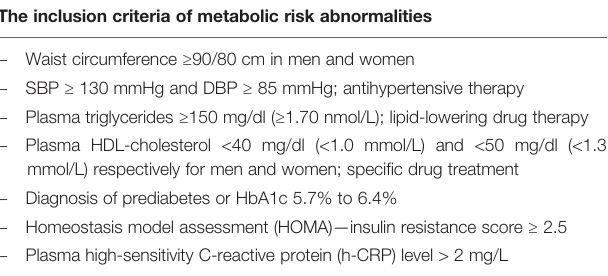
TABLE 1 | The inclusion criteria of metabolic risk abnormalities. The inclusion criteria of metabolic risk abnormalities − Waist circumference ≥ 90/80 cm in men and women − SBP ≥ 130 mmHg and DBP ≥ 85 mmHg; antihypertensive therapy − Plasma triglycerides ≥ 150 mg/dl ( ≥ 1.70 nmol/L); lipid-lowering drug therapy − Plasma HDL-cholesterol <40 mg/dl (<1.0 mmol/L) and <50 mg/dl (<1.3 mmol/L) respectively for men and women; speci fi c drug treatment − Diagnosis of prediabetes or HbA1c 5.7% to